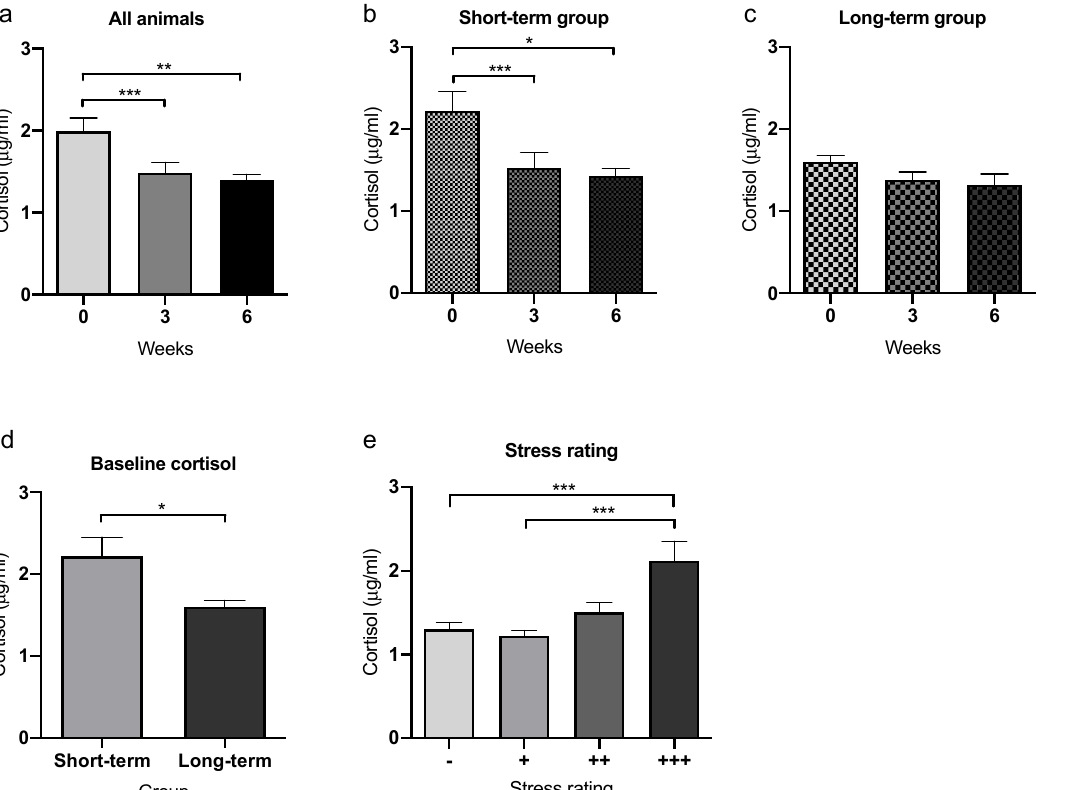
Figure 5. Quantification of blood cortisol concentrations and correlation with behavioral signs of distress. ( a ) Evaluation of cortisol concentrations in blood of female marmosets taken within the first 2 weeks after inclusion into the study as well as 3 and 6 weeks later. ( a ) Taking all tested animals together ( n = 19), blood cortisol was highest shortly after study inclusion and declined significantly until 3 ( p = 0.0002) and 6 ( p = 0.0064) weeks later. When divided into the short-term ( n = 12) and long-term ( n = 7) group, only animals in the STG ( b ) showed significant declines in cortisol levels over the next 6 weeks. ( c ) In animals in the long-term group, only minor variations in cortisol levels were detectable, but ( d ) with already significantly lower levels at the first time point of cortisol measurements (called baseline) ( p = 0.0121). ( e ) Correlation of blood cortisol levels with the behavioral stress rating, which was performed by the animal caretakers retrospectively without any information about laboratory parameters of the animals ( n = 9 animals with scoring at 48 time points in total). Animals with the strong behavioral signs of stress had highest blood cortisol concentrations. Bars represent mean ± SEM. * p < 0.05; ** p < 0.01; *** p < 0.001.